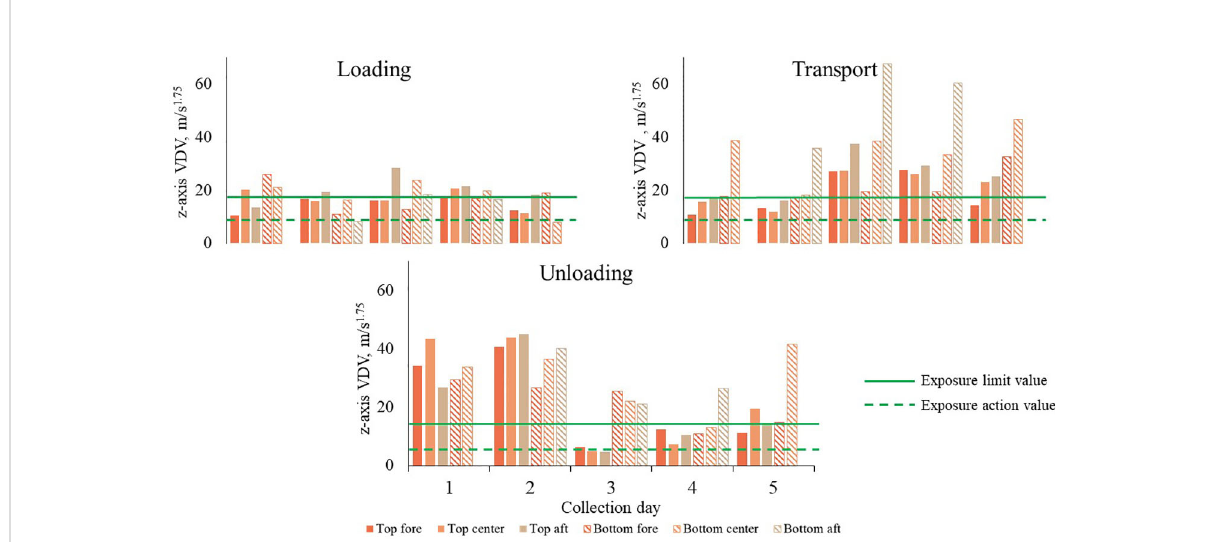
FIGURE 9 z-axis vibration dose value (VDV) experienced by pigs transported within two decks (DEC>; T, Top; B, bottom) and three sections (SEC; F, fore; C, center; A, aft) of two trailers during loading (LOD), transport (TRA), and unloading (UDL). Least squares means encompass two daily market-weight pig loads recorded over fi ve consecutive days. Exposure action value (EAV; 8.5 m/s 1.75 ; dotted green line) and exposure limit value (ELV; 17 m/s 1.75 ; solid green line) correspond to “ injury possible ” and “ injury likely ” comfort levels, respectively.